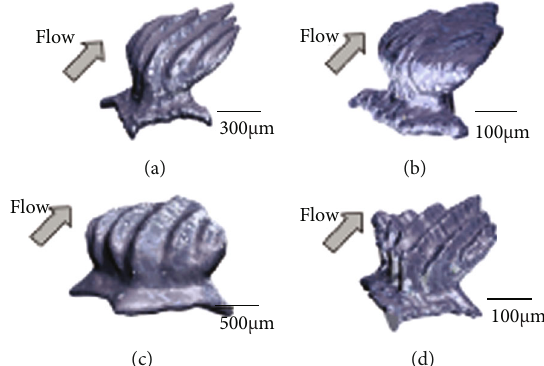
Figure 16: Three-dimensional structures of single dentition of di ff erent sharks: (a) Galapagos shark, (b) great white shark, (c) whitetip reef shark, and (d) blacktip reef shark